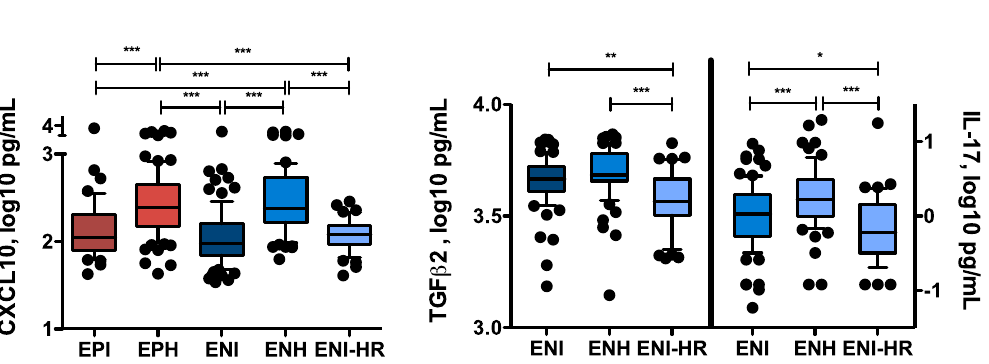
Figure 4. CXCL10, TGF- β 2 and IL-17 titers in different phases of chronic HBV infection. ( A ) CXCL10 levels in HBeAg-positive and HBeAg-negative phases of chronic HBV infection ( B ) TGF- β 2 and IL-17 levels in HBeAg- negative phases of chronic HBV infection. Mann-Whitney U test was used for comparison of